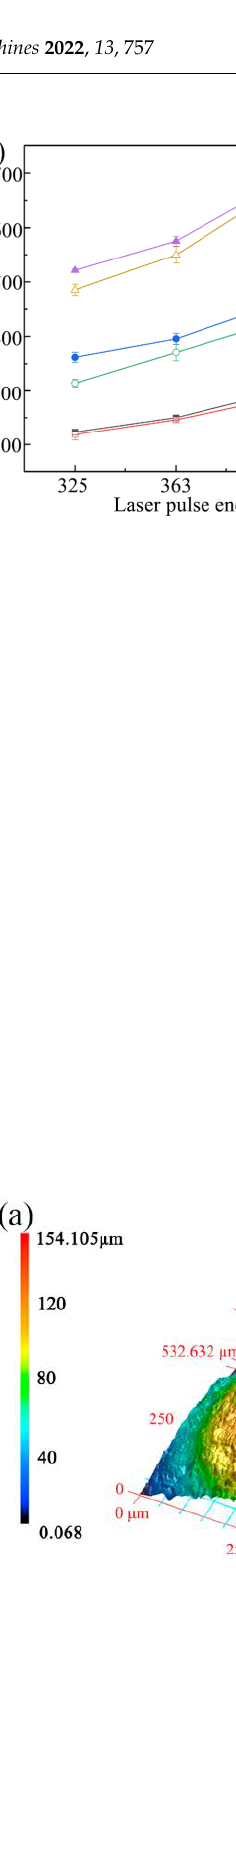
Figure 7. ( a ) 3D topography of bulging samples; ( b ) measurement value of surface roughness of bulging samples; ( c ) roughness curve. 3.3. Microstructure Morphology The section morphologies of bulging samples under different laser shock energies are observed. The influence of laser pulse energy on bulging samples is shown in Figure 8a. The plastic strain increases with the increase of laser energy, and the deformation pro ‐ cess of bulging sample can be summarized as five stages: uniform plastic deformation, local necking, cracks in the bulging zone, complete fracture in the bulging zone and com ‐ plete rupture at the mold entrance zone. The grain size and mold characteristic size seri ‐ ously affect the formability of bulging samples. As shown in Figure 9, when the laser pulse energy is 447 mJ, the fine ‐ grained bulging sample is in stage 1, while the coarse ‐ grained bulging sample is already in stage 2 when λ = 0.5. Meanwhile, the fine ‐ grained bulging sample is in stage 1 when λ = 0.25 and 0.5, and it is already in stage 2 when λ = 1. Therefore, too large a grain size and mold characteristic size are not conducive to the micro ‐ bulging technology of metal foil in the micro ‐ forming process. Combined with the previous sec ‐ tion, too small a mold characteristic size leads to poor surface quality of bulging sample. Therefore, for metal foil with specific grain size and workpiece thickness, there is an ap ‐ propriate mold characteristic size to obtain better surface quality and formability.